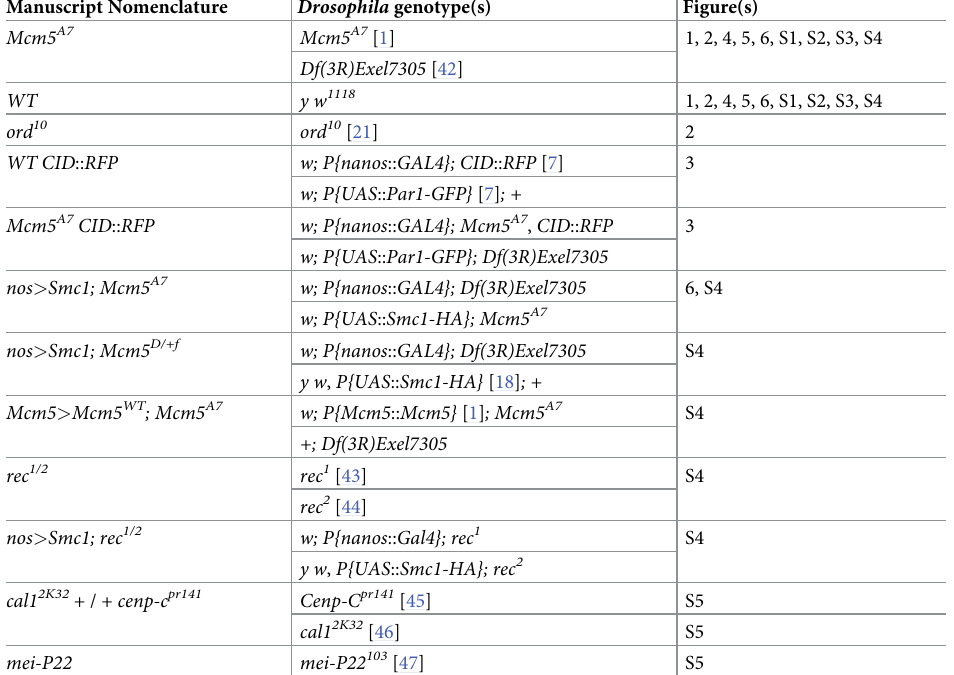
Table 1. Genotypes used in this